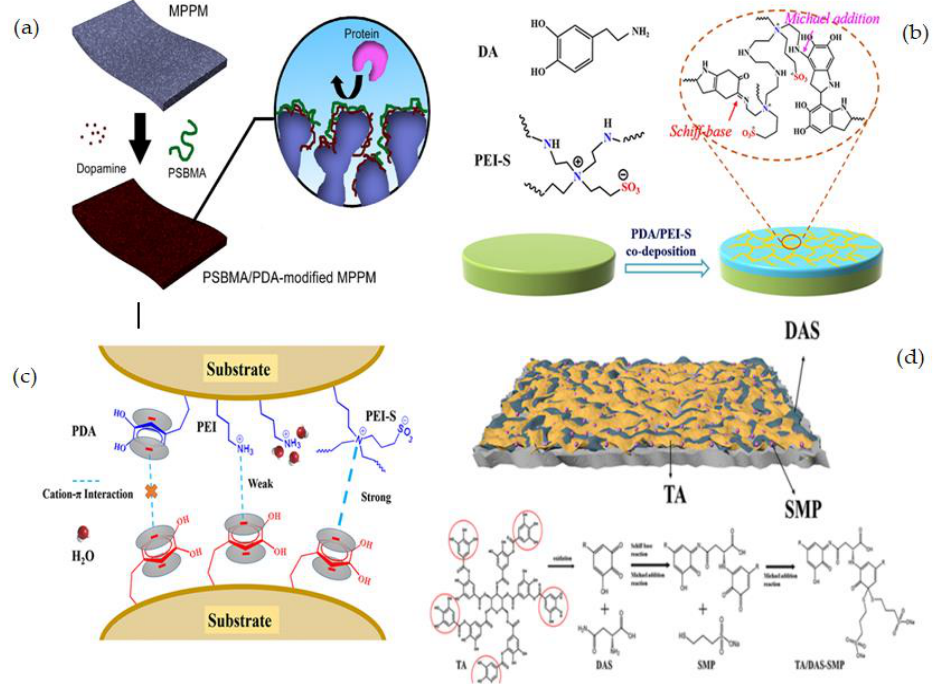
Figure 6. ( a ) Schematically illustration of co-deposition of PSBMA/PDA on MPPM membrane surface [120], ( b ) Synthetic procedure of PES/M-PDA/PEI-S [121], ( c ) Representative interaction between PDA, PEI, and PEI-S [121], ( d ) The reaction mechanism of TA/DAS-SMP [122].